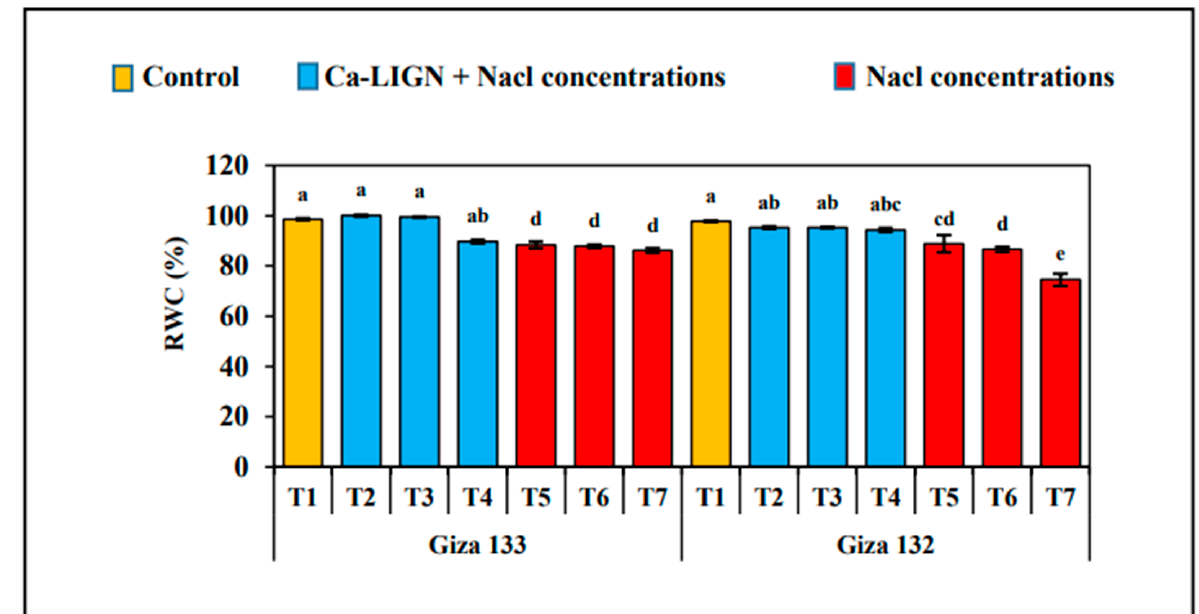
Figure 3. Effect of different treatments: (T1) control, (T2) 100 mM NaCl + Ca-LIGNO, (T3) 200 mM NaCl + Ca-LIGNO, (T4) 300 mM NaCl + Ca-LIGNO, (T5) 100 mM NaCl, (T6) 200 mM NaCl, and (T7) 300 mM NaCl on the average ( A ) leaf area (LA) and ( B ) total leaf area (TLA) of the two barley cultivars, Giza133 and Giza132, during two seasons, 2019/2020 and 2020/2021. Data represent the mean ± SE (n = 4). The same letter indicates no significant difference ( p ≤ 0.05).